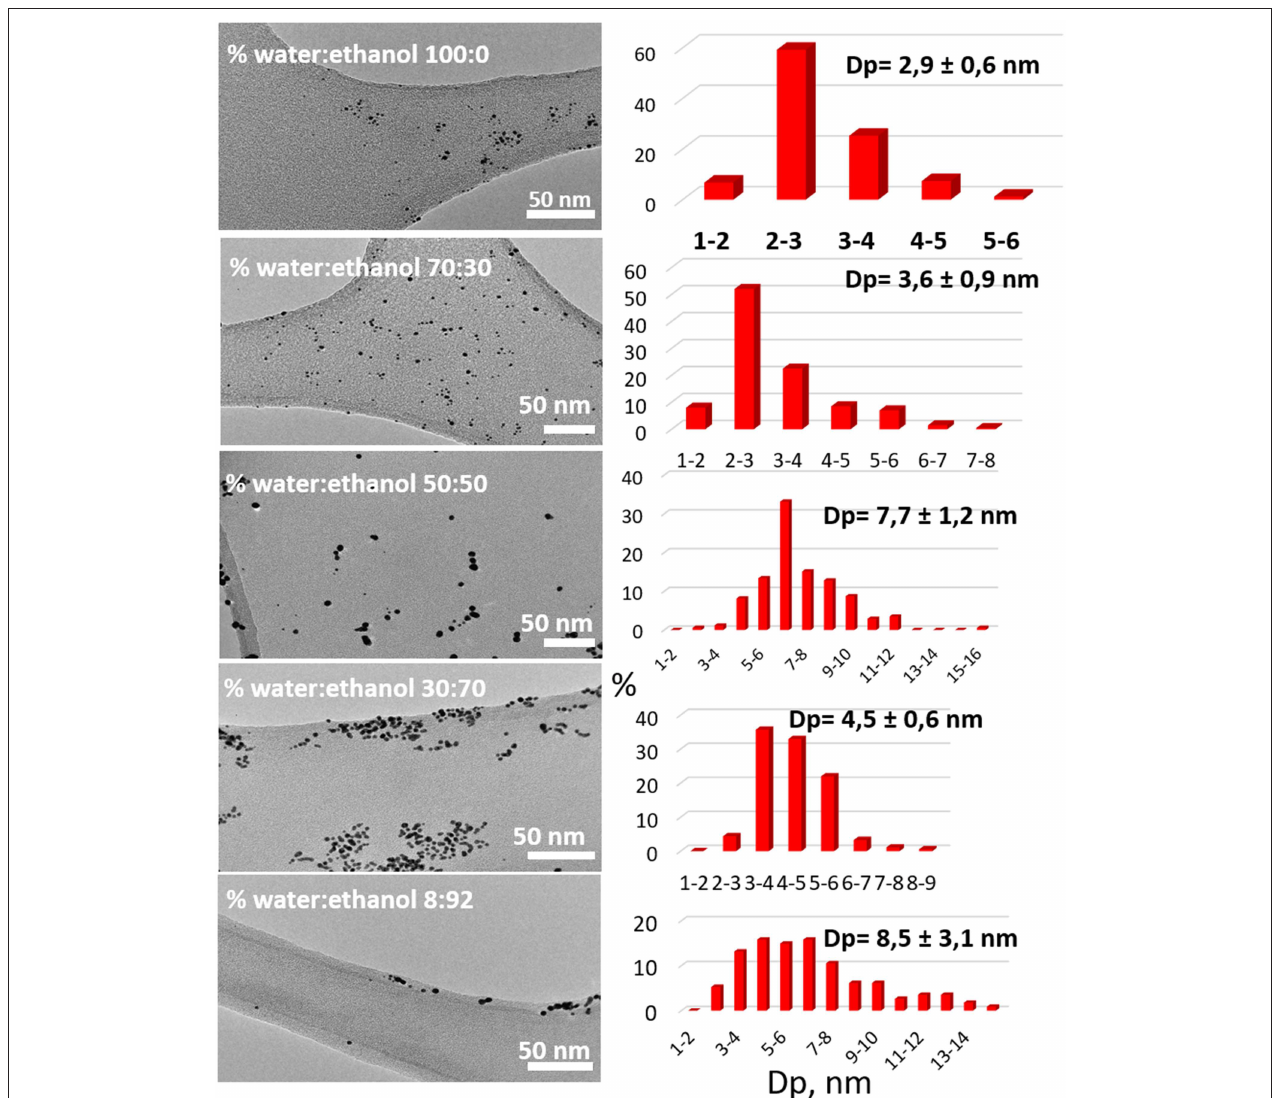
FIGURE 2 | TEM micrographs, particle size distribution, and average gold particle size (Dp) for the obtained